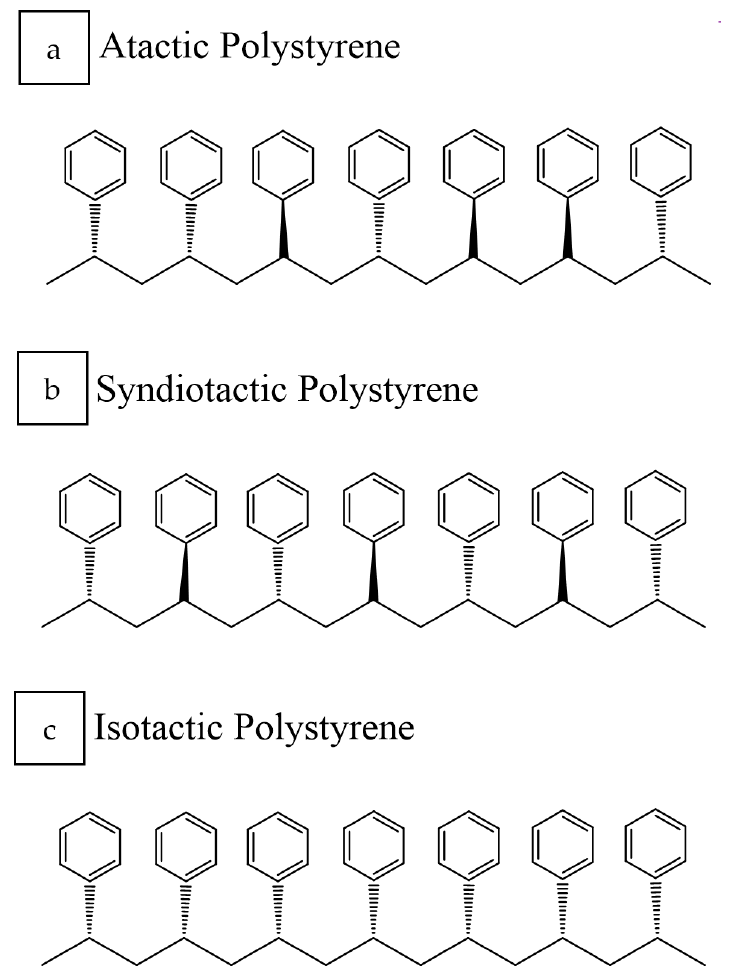
Figure 3. Different forms of